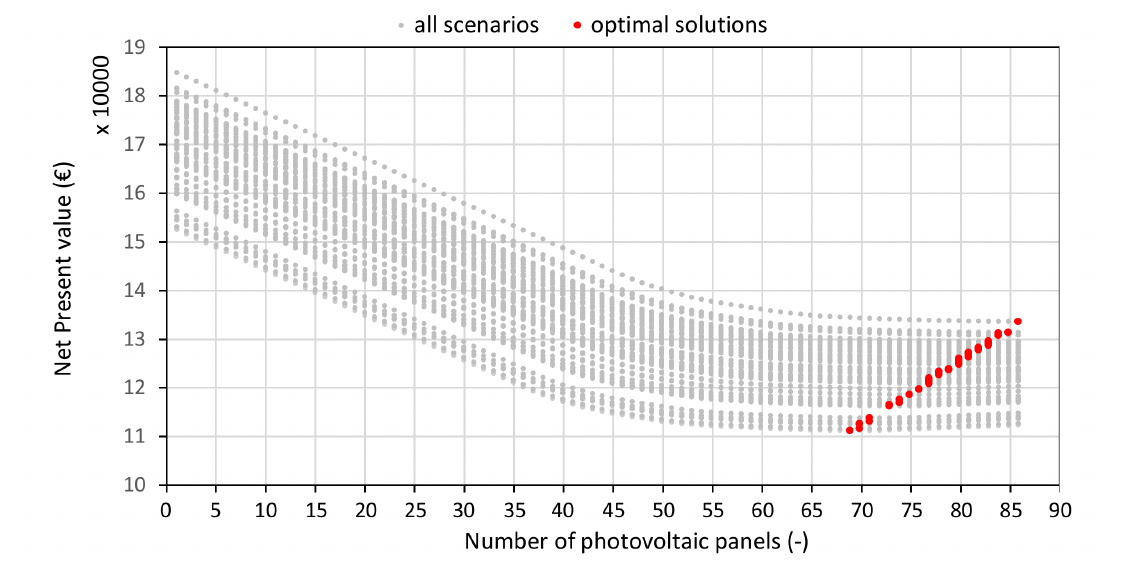
Figure 10. Optimum number of photovoltaic panels for Model Id. 22.